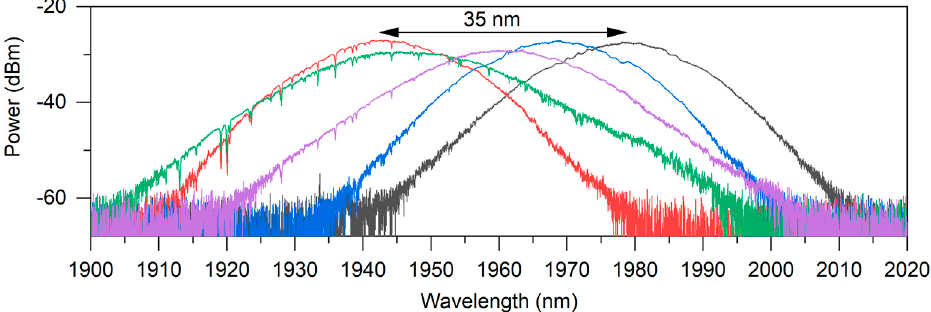
Figure 5. NLP output spectrum tuning at a pump power of 1.3